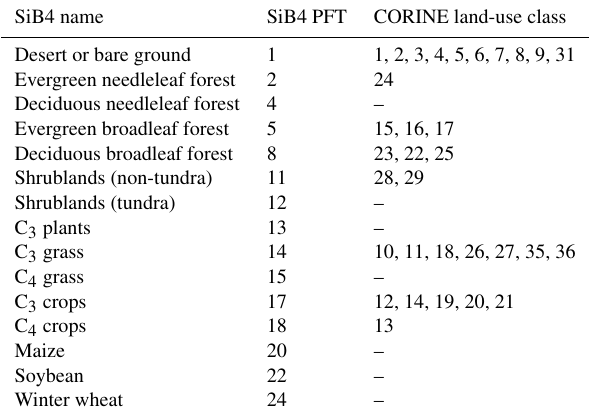
Table 5. SiB4 PFT names and their corresponding CORINE land- use classes’ grid codes. For the CORINE classification, see http: //clc.gios.gov.pl/doc/clc/CLC_Legend_EN.pdf (last access: 27 Jan- uary